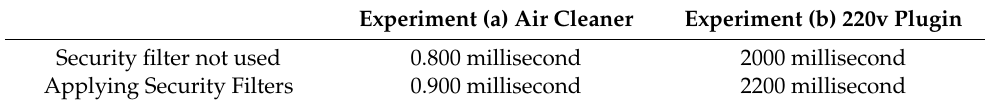
Table 3. Device response time when security filter is applied in normal state.